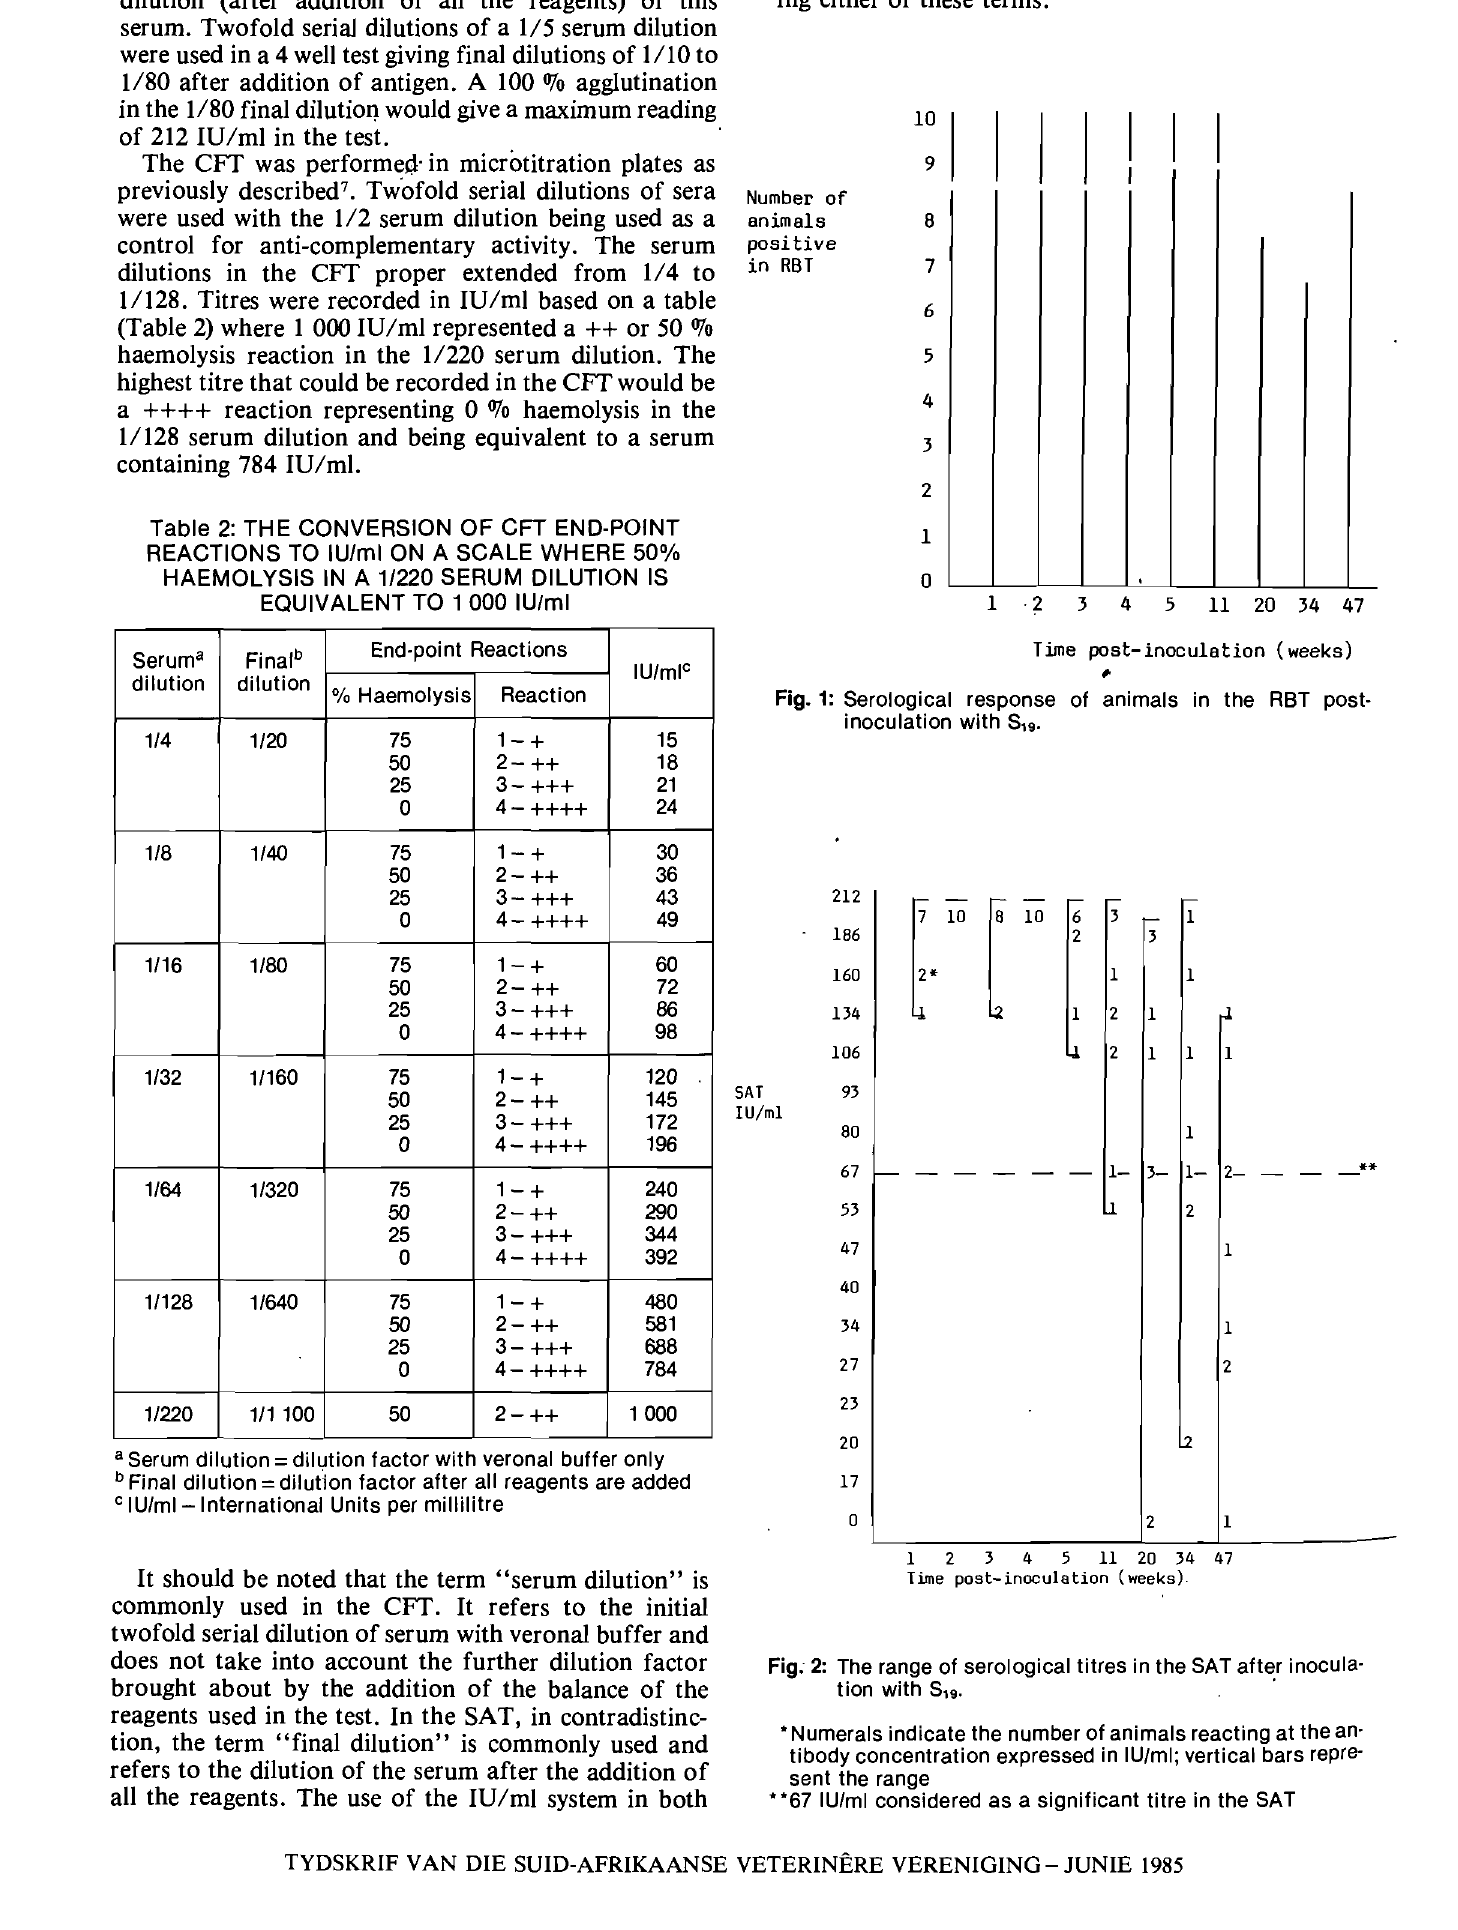
Table 2: THE CONVERSION OF CFT END·POINT